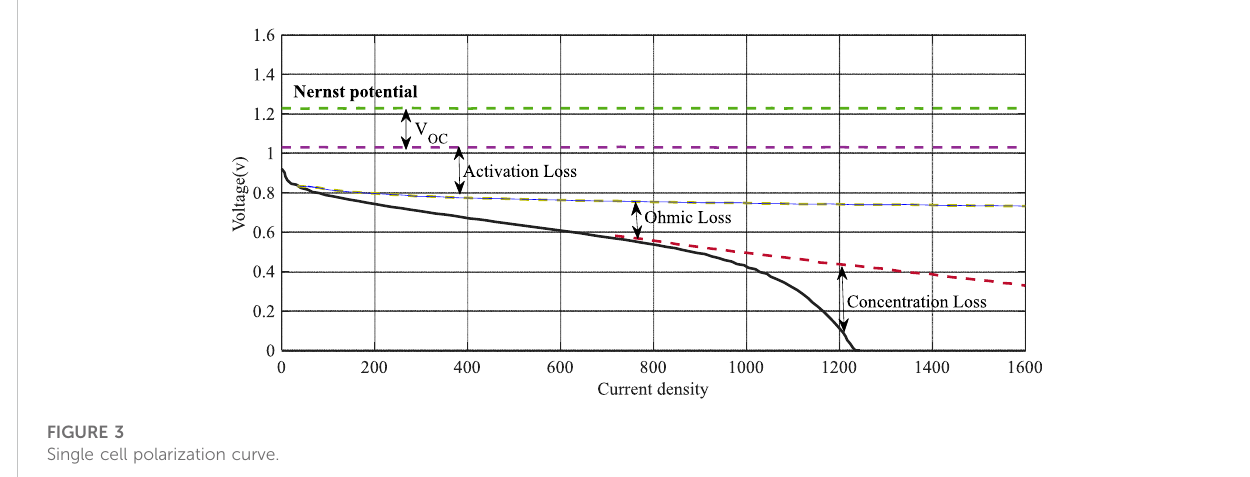
FIGURE 3 Single cell polarization